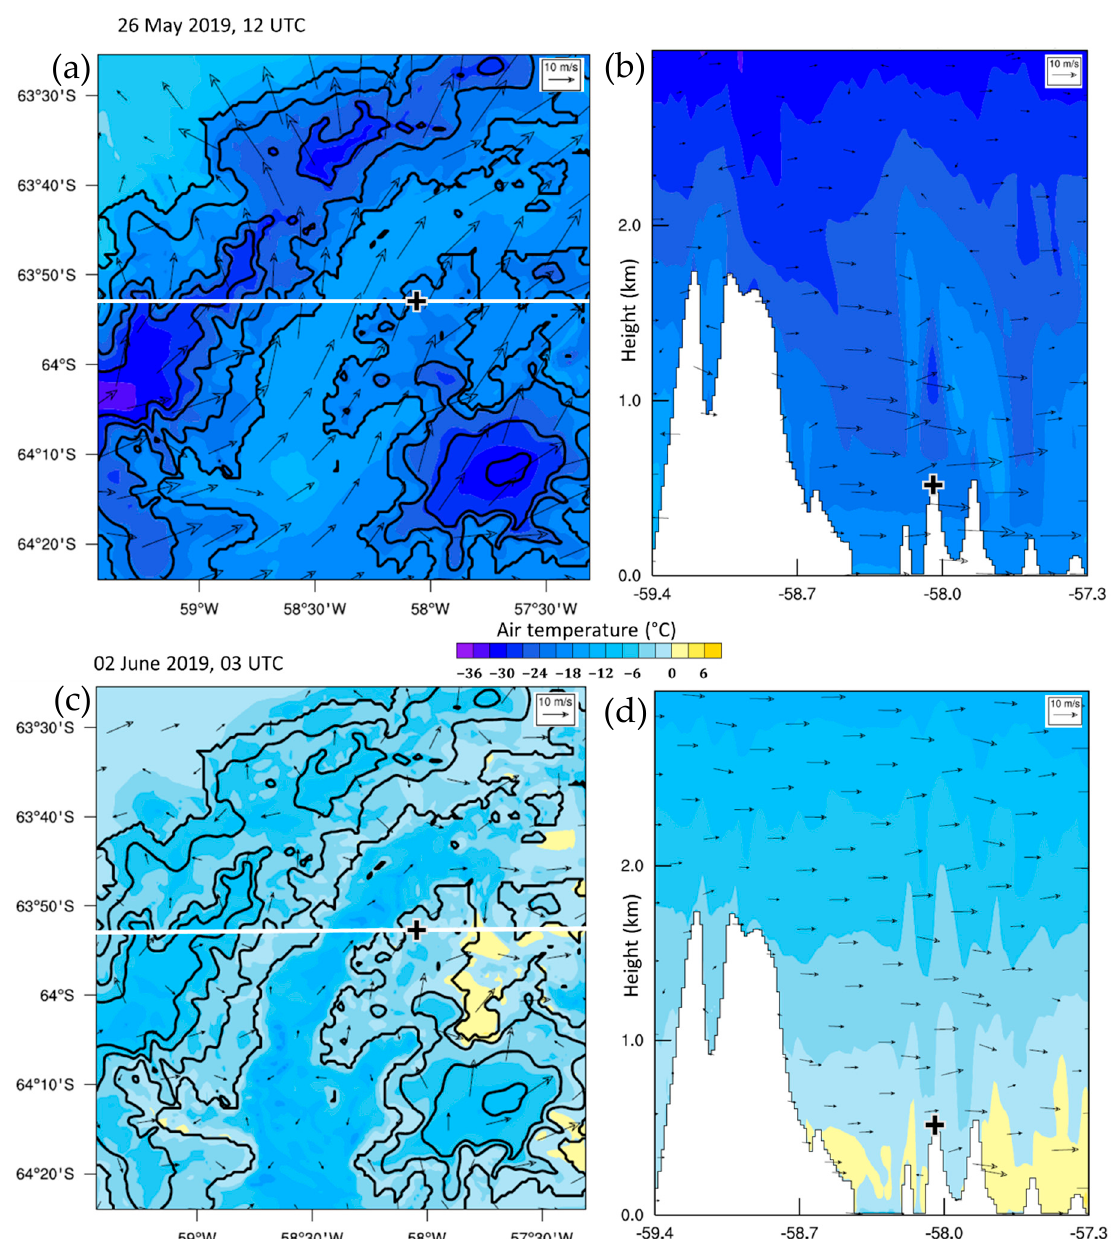
Figure 7. Surface air temperature and wind fields ( a , c ) and vertical cross-sections ( b , d ) through WRF domain d3 on 26 May 2019 at 12 UTC and 2 June 2019 at 03 UTC. Cross-sections are led via Davies Dome (black cross) and shown in maps by white lines. Contour lines at 500 m intervals are given in black. The WRF output with the QNSE BL scheme was selected for the figure preparation as this scheme was designed for stably stratified boundary layer [67].